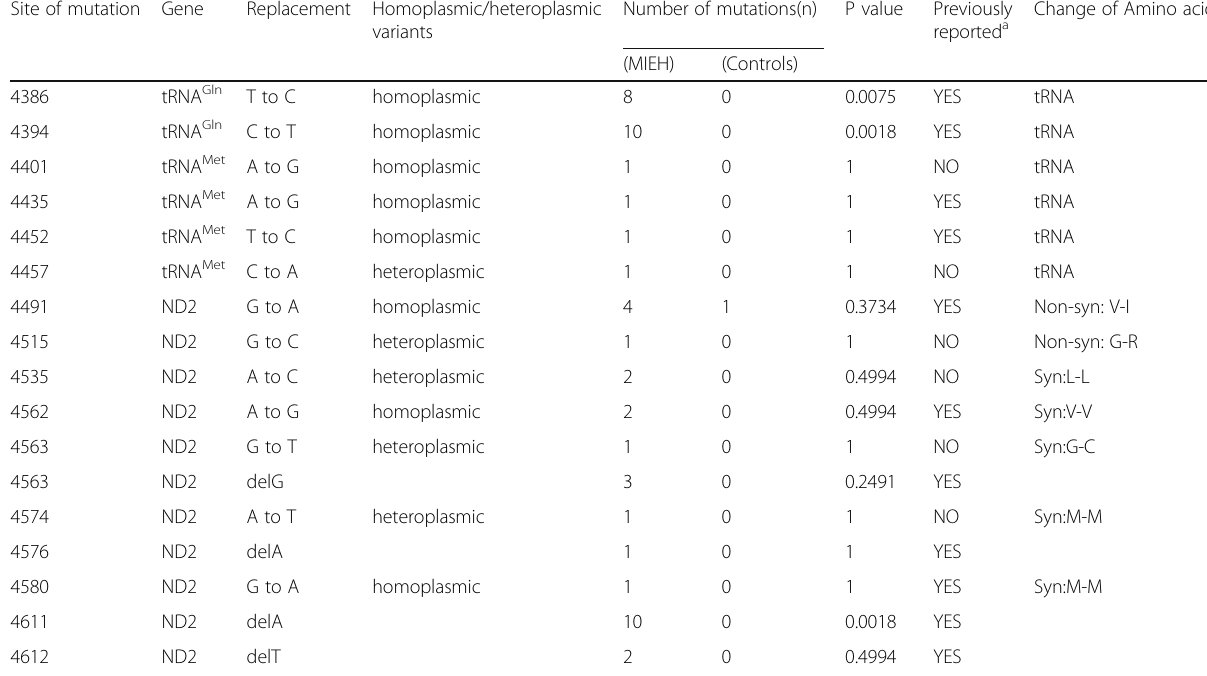
Table 3 Mutation sites of mtDNA in MIEH individuals and controls (Continued) Site of mutation